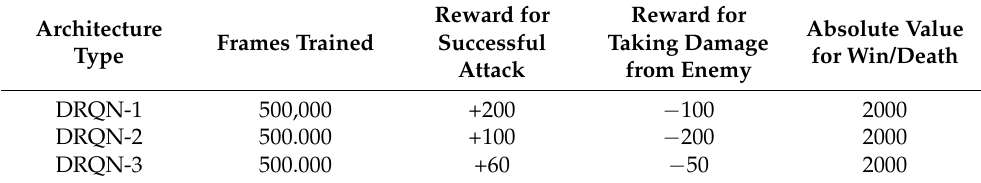
Table 2. Reward table for the DRQN